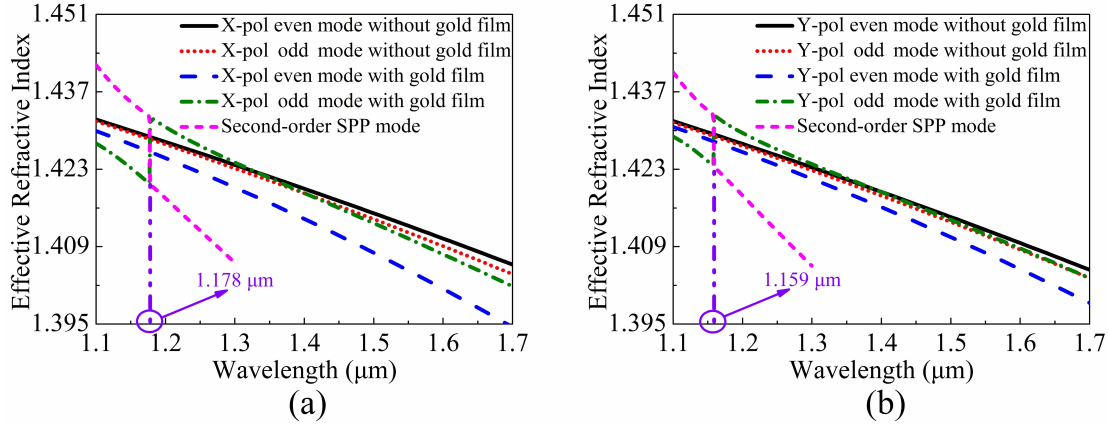
Figure 2. The ERIs of the ( a ) X-pol and ( b ) Y-pol even and odd modes and second-order surface plasmon polariton (SPP) mode calculated as functions of wavelength when the V-DC-PCF is coated without gold film and with gold film,